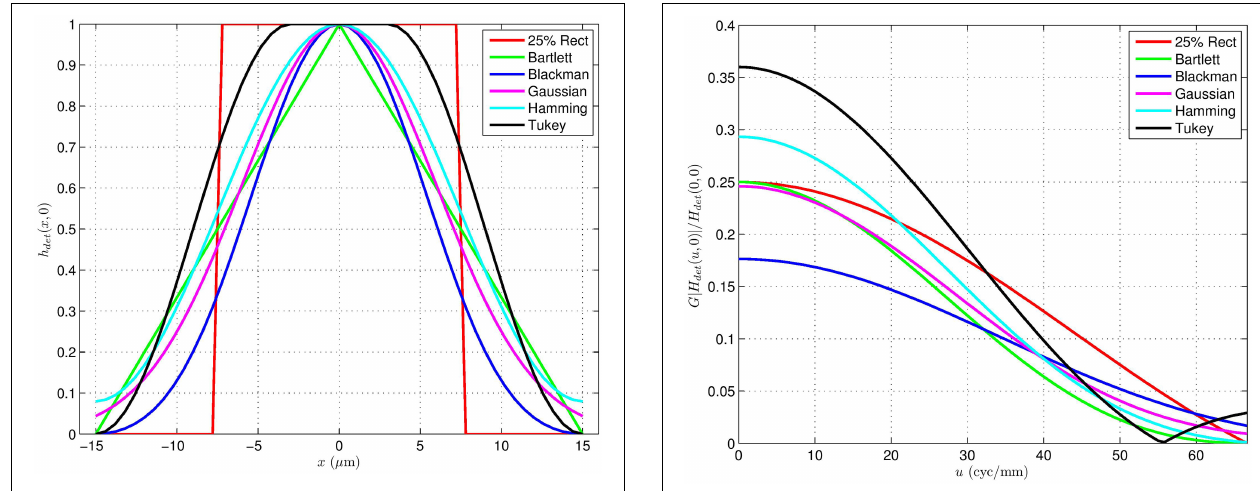
FIGURE 17 | Cross-sections of separable active areas for a pitch of p = 30 μ m based on standard window functions. These correspond to variable response detectors, in contrast with binary active area detectors.